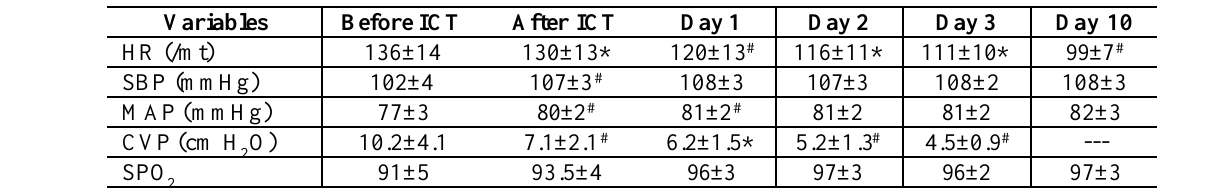
Table I : Serial haemodynamic changes in Children with acute empyema